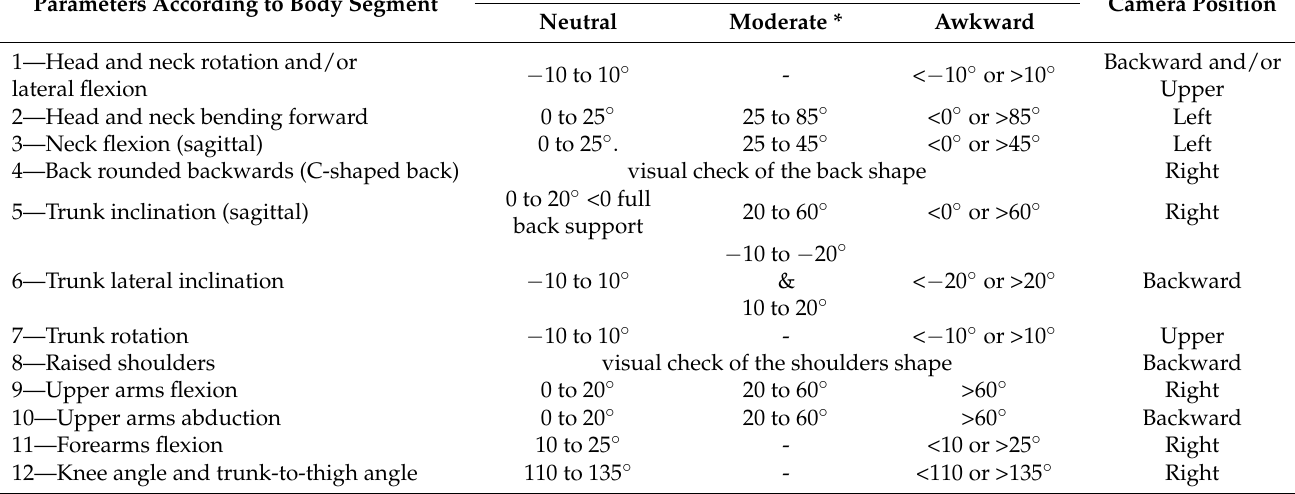
Camera Position